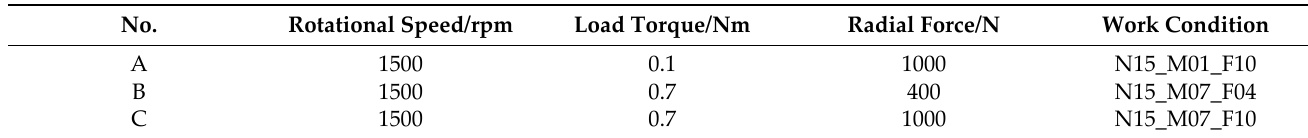
Figure 10. Schematic diagram of the bearing experiment system for obtaining PU dataset. Table 5. Work conditions for obtaining PU dataset.